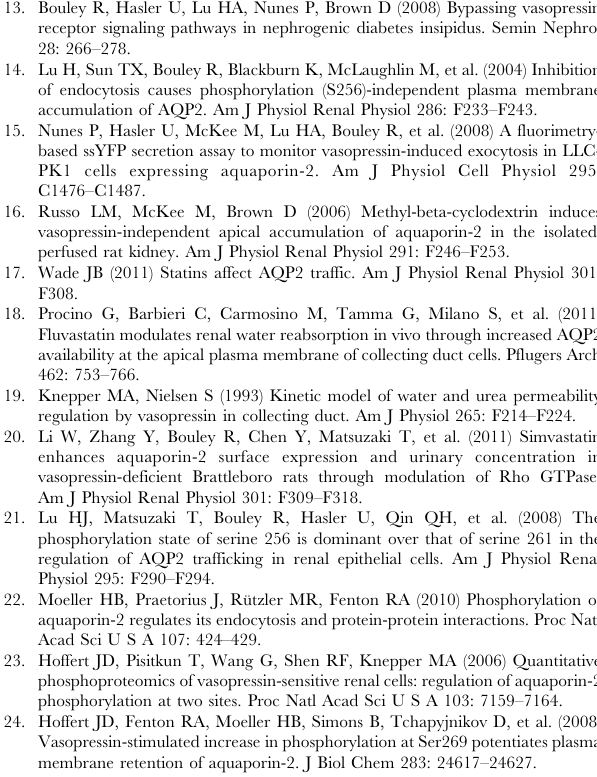
Figure S2 Quantification of colocalization between AQP2 and markers of the subcellular compartment. compartment marker is presented for 0, 45, and 120 minutes of cold data set, the colocalizations were calculated from multiple individual cells in confocal microscope stacks taken at a step size of 1 m m. Means are presented with standard error bars. Despite the formation of a tight perinuclear patch in the same vicinity as the Golgi apparatus, as can be observed in Figure 6, only a small fraction (generally sub 15%) of AQP2 is colocalized on a